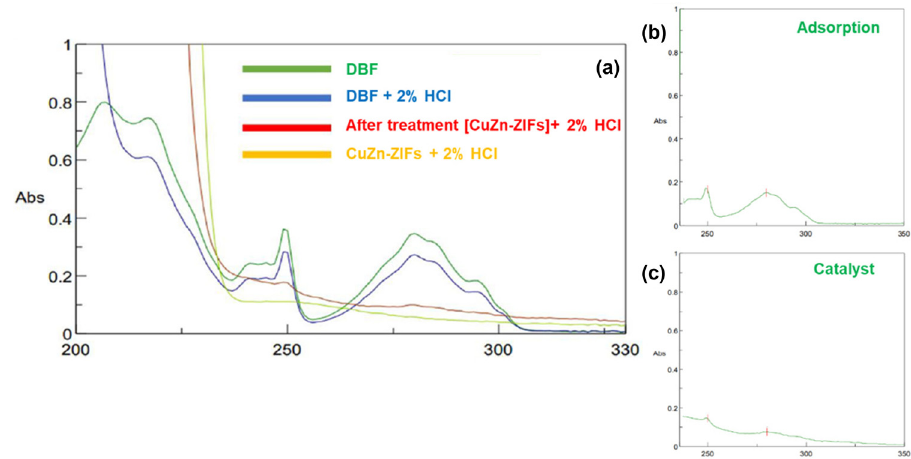
Figure 7: UV - Vis spectrum of DBF residue after CuZn - ZIFs recovery during adsorption and catalyst process. ( a ) Spectrum of DBF residue in CuZn - ZIFs before and after treatment compared with DBF alone and HCl addition for catalyst process, ( b ) DBF residue in the adsorption process, and ( c ) DBF residue in catalyst